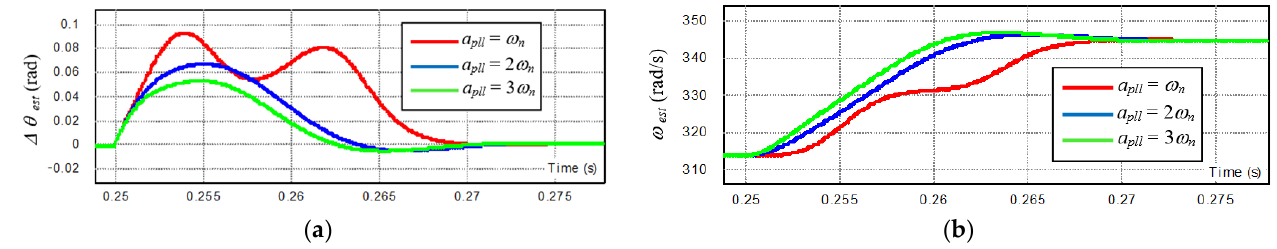
Figure 13. The estimated phase angle error ( a ) Δ θ est and estimated frequency ( b ) ω est for three different a pll values, for the FFPLL with the positive sequence separation.